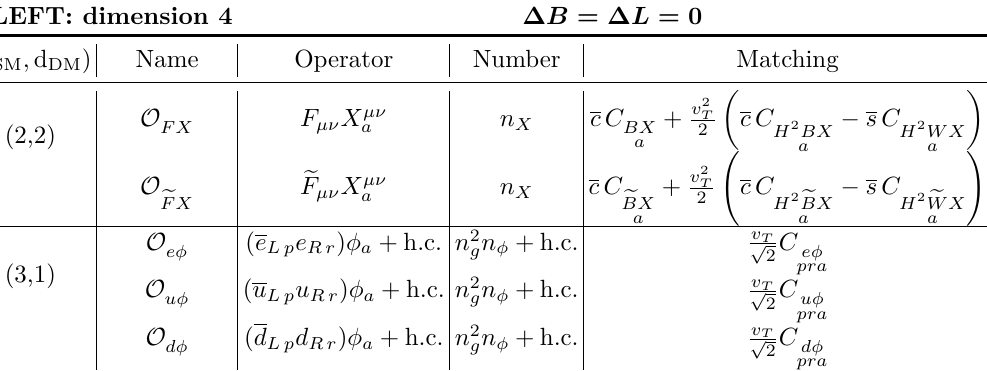
Table 18 . Dimension-four ∆ B = ∆ L = 0 operators in DLEFT. Note that O Q , etc. The first column gives the dimensions of the SM and DM part of the operator, the fourth eφ column is the number of operators, and the fifth column is the additional matching contribution at the EW